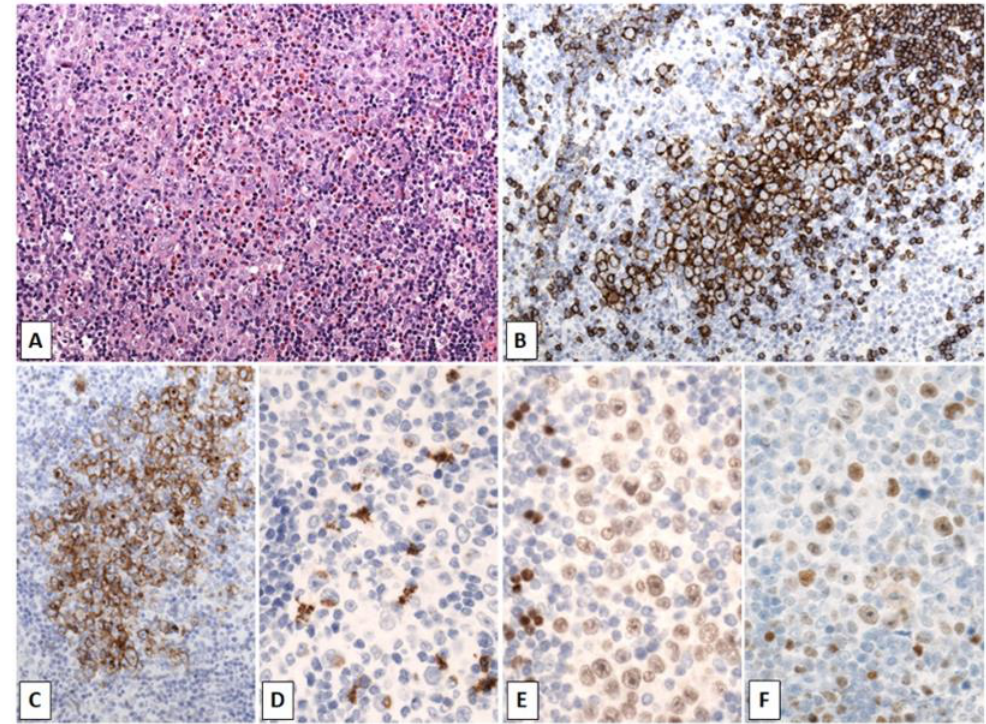
Figure 1. Mediastinal grey zone lymphoma. Mediastinal mass in a 16-year-old female with a nodu- lar growth of relatively monotonous large cells with some lacunar cells and eosinophils ( A ). Strong positivity for CD20 ( B ) and CD30 ( C ). CD15 was focally weakly positive in a perinuclear dot-like fashion ( D ). Relatively weak expression of PAX5 ( E ), Oct-2 ( F ) and heterogeneous expression of CD79a (not shown). (Original magnification: A ×100, B,C ×200, D, E and F ×400).